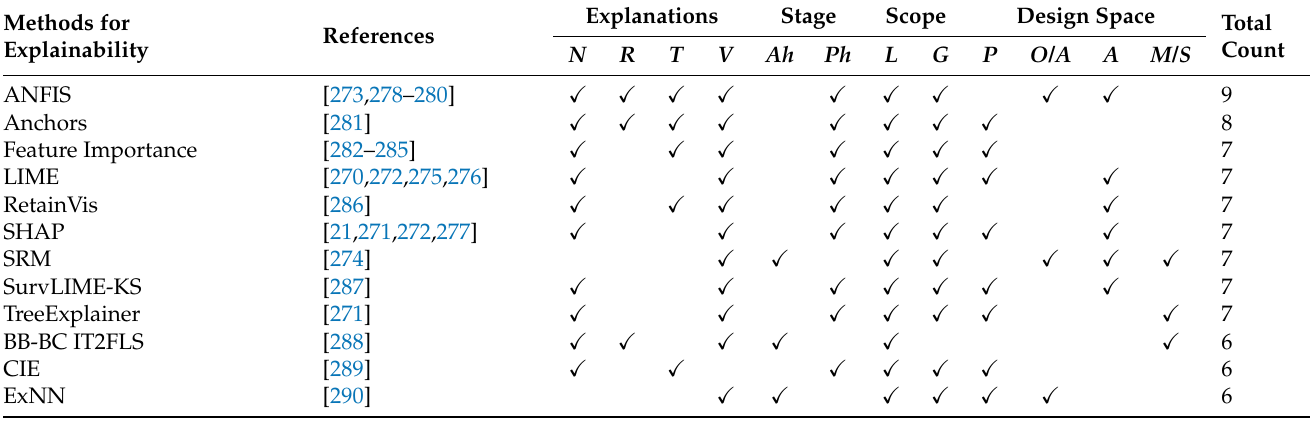
Table 6. XAI methods with associated types of explanations ( N : Numeric, R : Rules, T : Textual, V